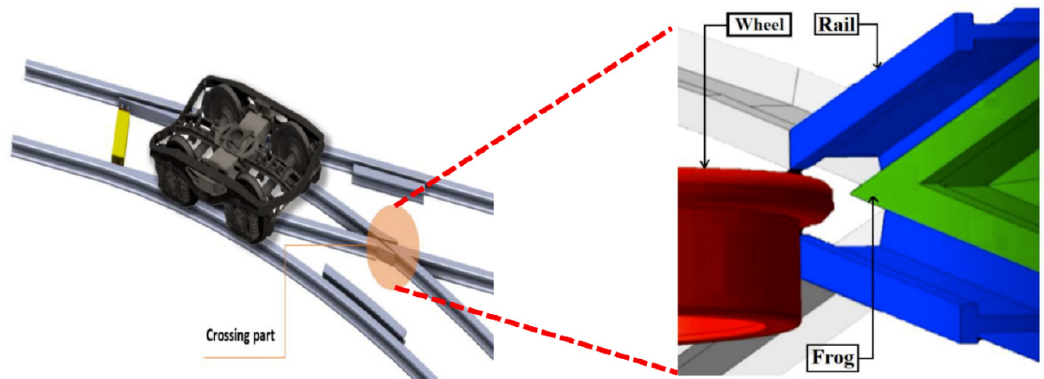
Figure 1. Railway switches and crossings.